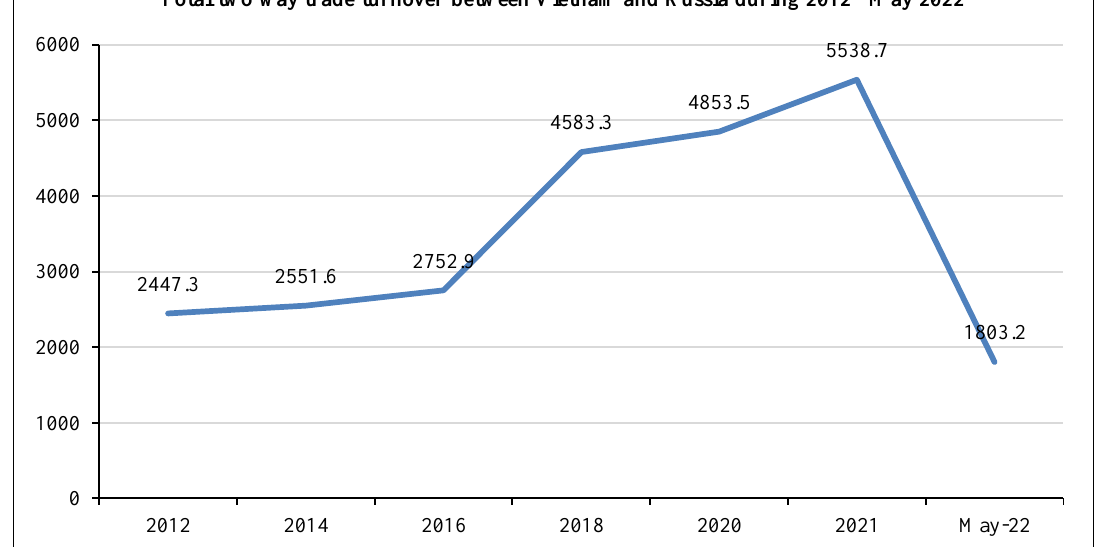
Figure 2. Total two-way trade turnover between Vietnam and Russia during 2012 - May 2022 ( Unit: Million USD)